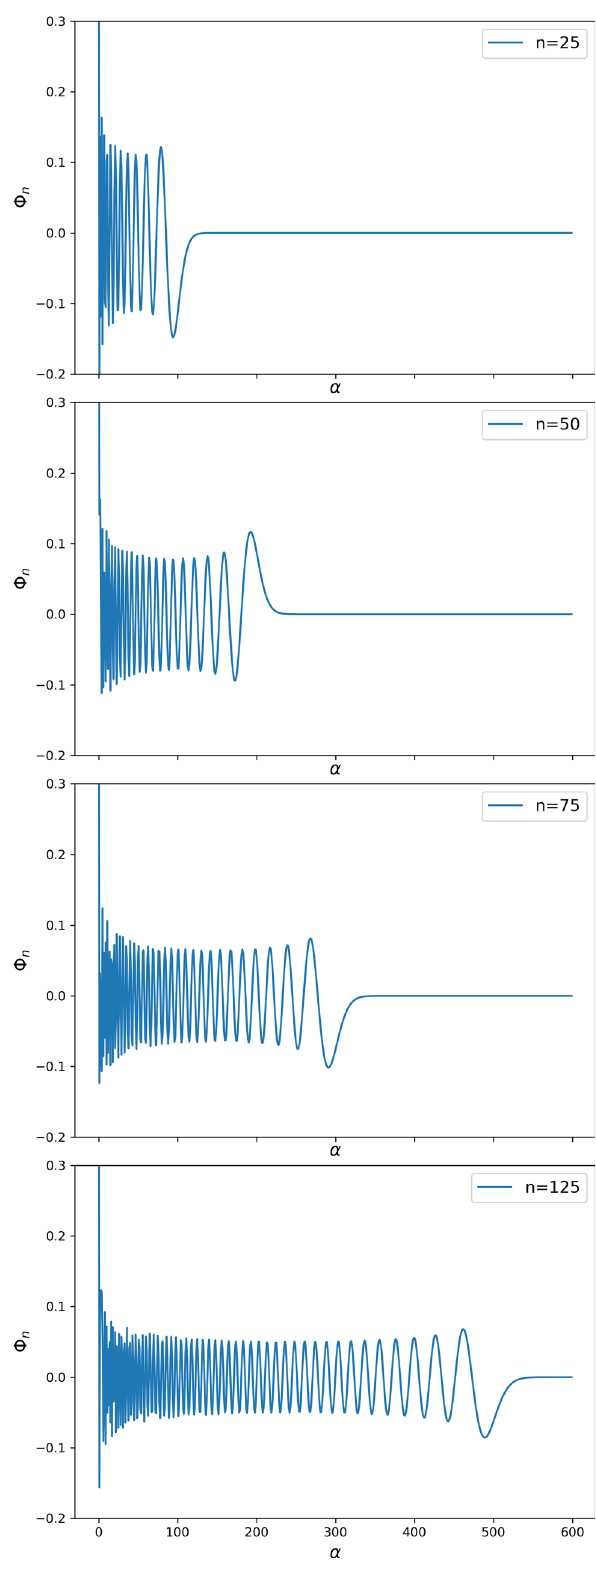
Fig. 1 Oscillatory behaviour of the functions Φ n for various values of the Landau level ( n = 25 , 50 , 75 , 125 ) . The oscillatory region is bounded by α ≈ 4